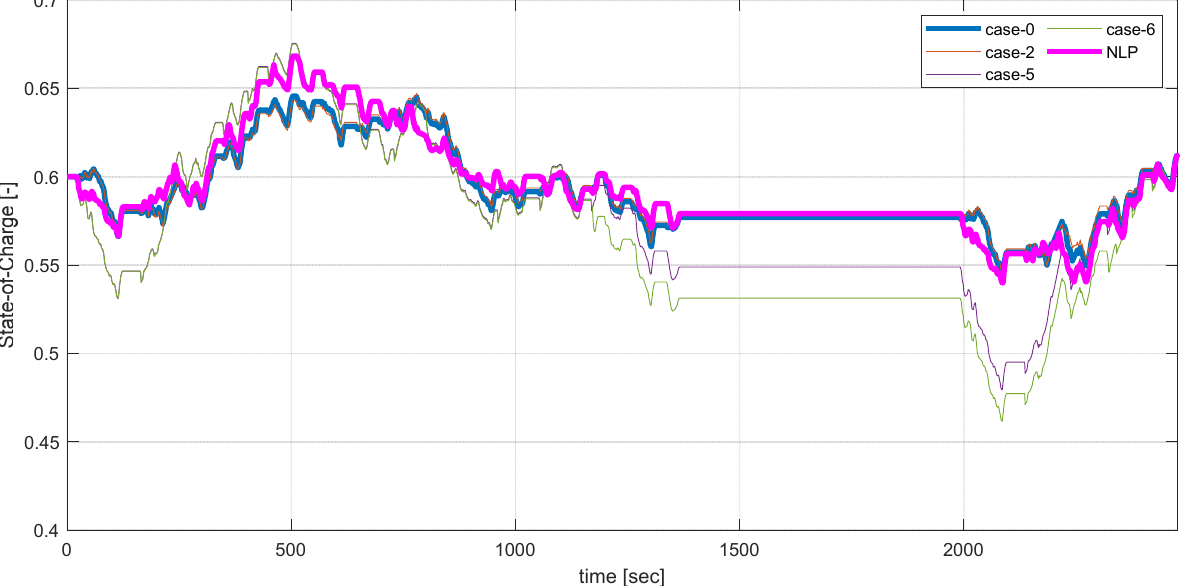
Figure 11. Comparison of NLP results to DP results (2): reference SOC trajectory.